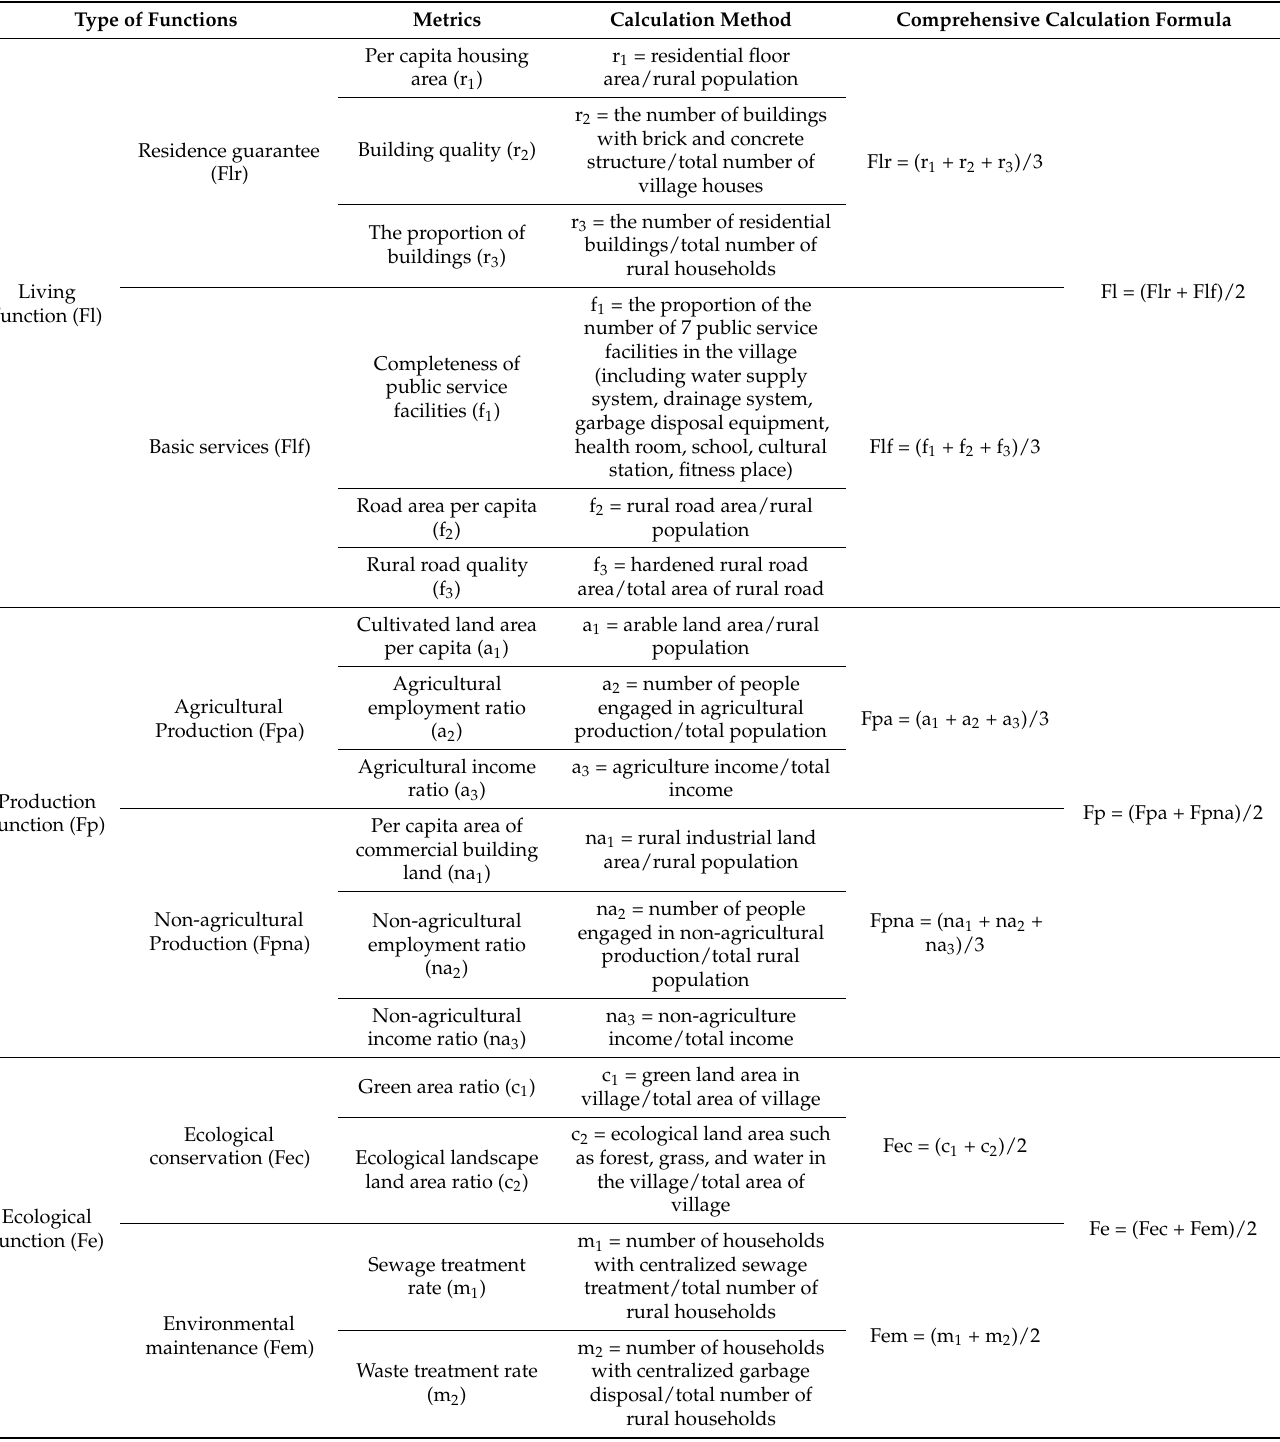
Table 2. Multi-functional index system and calculation method of rural residential